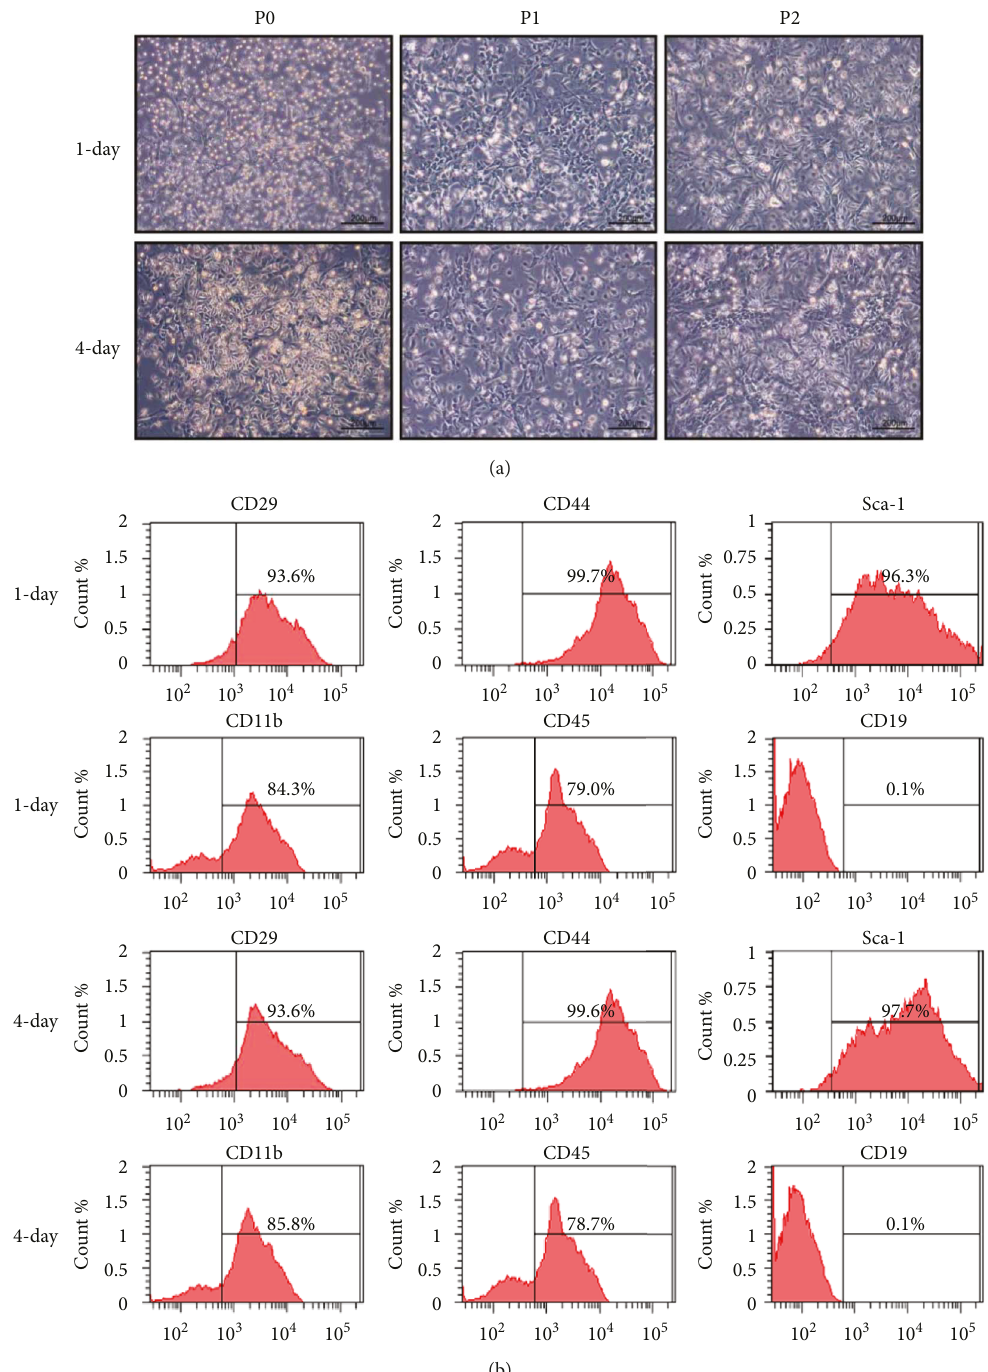
Figure 3: The e ff ect of the di ff erent initial medium replacement intervals on cellular morphology and surface markers of BM-MSCs cultured in 5% oxygen condition. (a) Phase contrast images ( × 100 with scale bar = 200 μ m) of BM-MSCs at P0, P1, and P2. (b) The expression of CD29, CD44, Sca-1, CD11b, CD45, and CD19 surface markers of BM-MSCs at P2 determined by fl ow